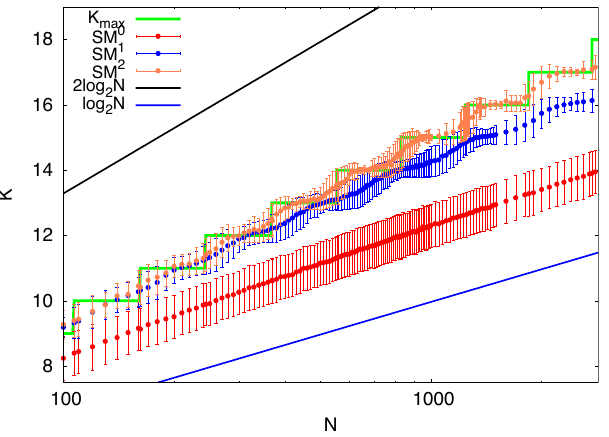
Figure 5. Mean and standard deviations of sizes of the maximal cliques from Erdös-Rényi graphs 0, 1, 2 . The maximum size of a clique as a function of the G ( N , p 0.5 ) , using the algorithms SM i , with i = = order of the graph is represented by the green staircase K max . The black and the blue straight lines show 2log 2 N and log 2 N , respectively. Red data points describe the mean maximal clique size obtained by SM 0 , averaging over 2000 Erdös-Rényi graphs. Blue points describe the maximal clique size found with SM 1 , while orange points are the results of SM 2 . The average is obtained over 500 and 100 graphs for SM 1 and SM 2 , respectively.